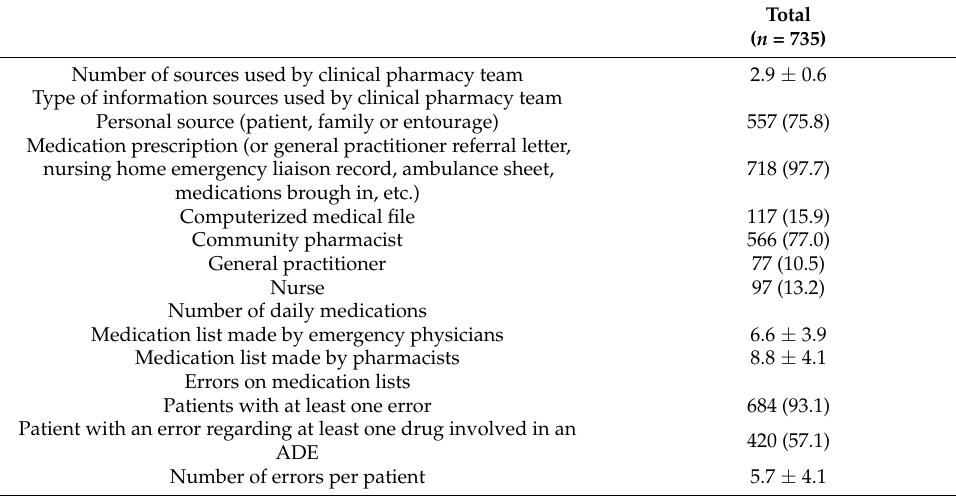
Table 2. Best possible medication history, number of daily medications and medication reconciliation